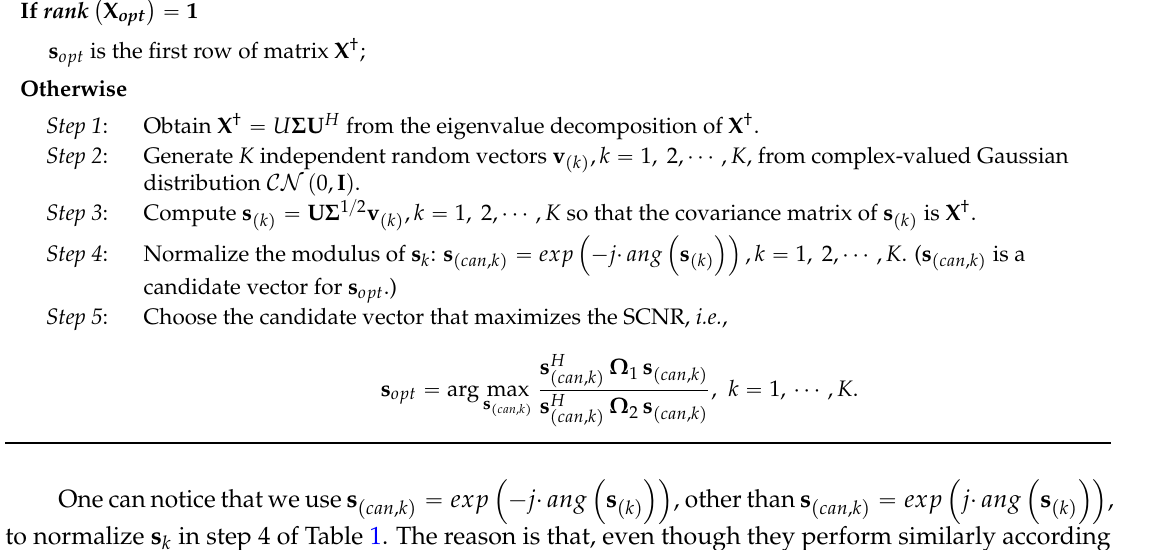
Table 1. Customized randomization approach